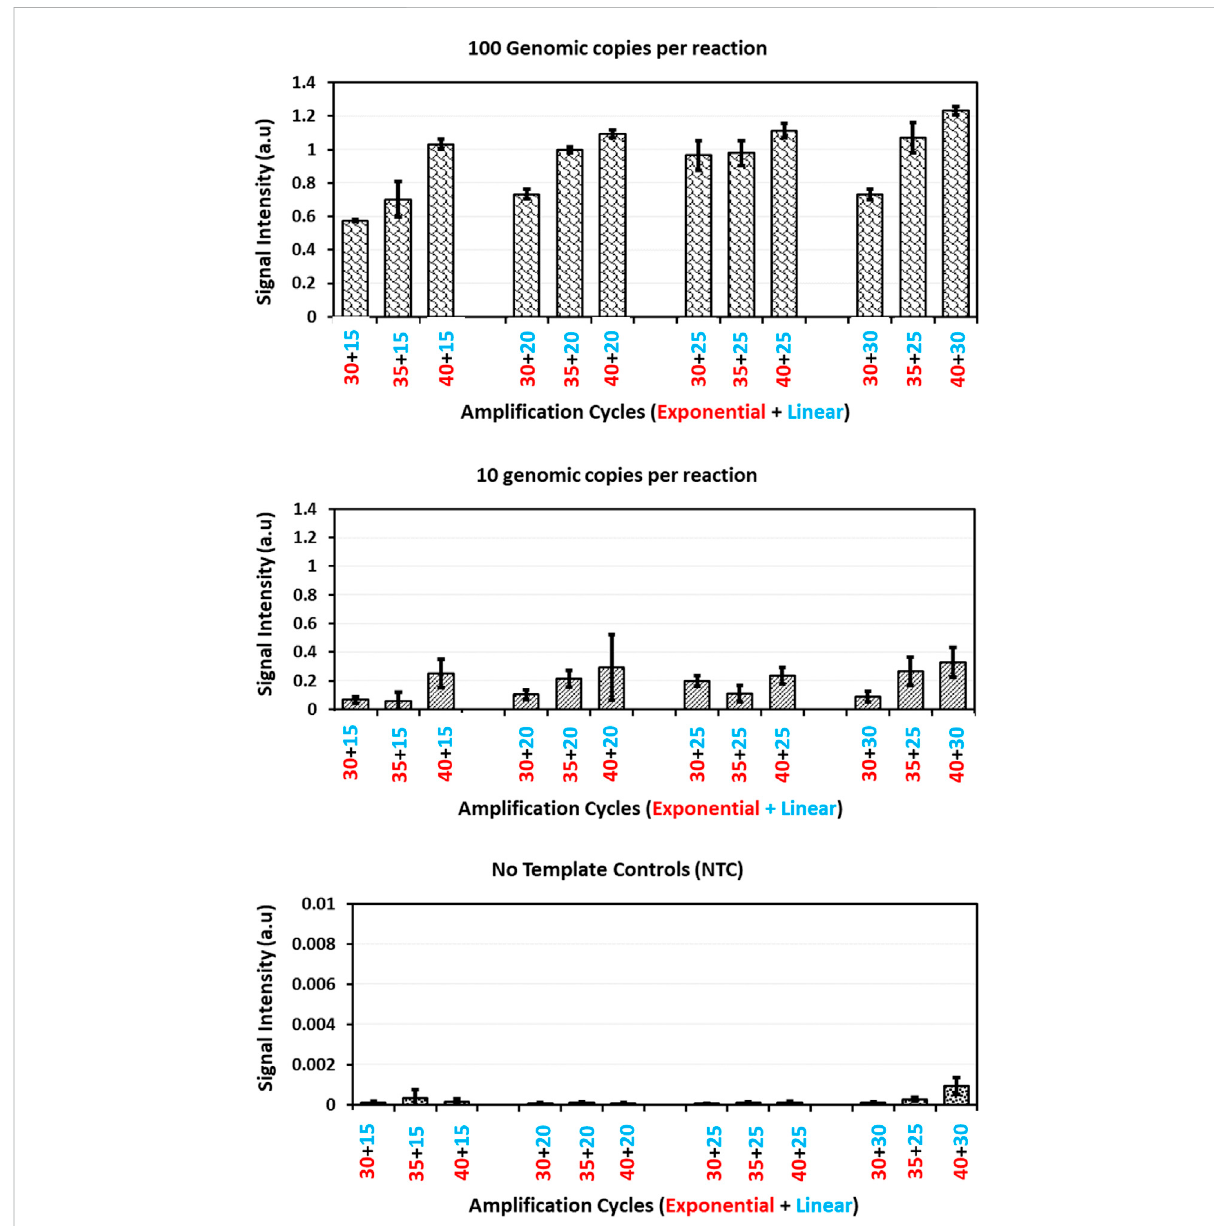
FIGURE 3 Guard banding of ampli fi cation cycles: Signal intensities obtained for Staphylococcus aureus probe after ampli fi cation of Staphylococcus aureus copy number dilutions (100, 10 genomic copies and no template control) with different ampli fi cation cycles patterns and hybridization onto microarray. The error bars represent standard deviation across fi ve replicates for each dilution in a respective ampli fi cation